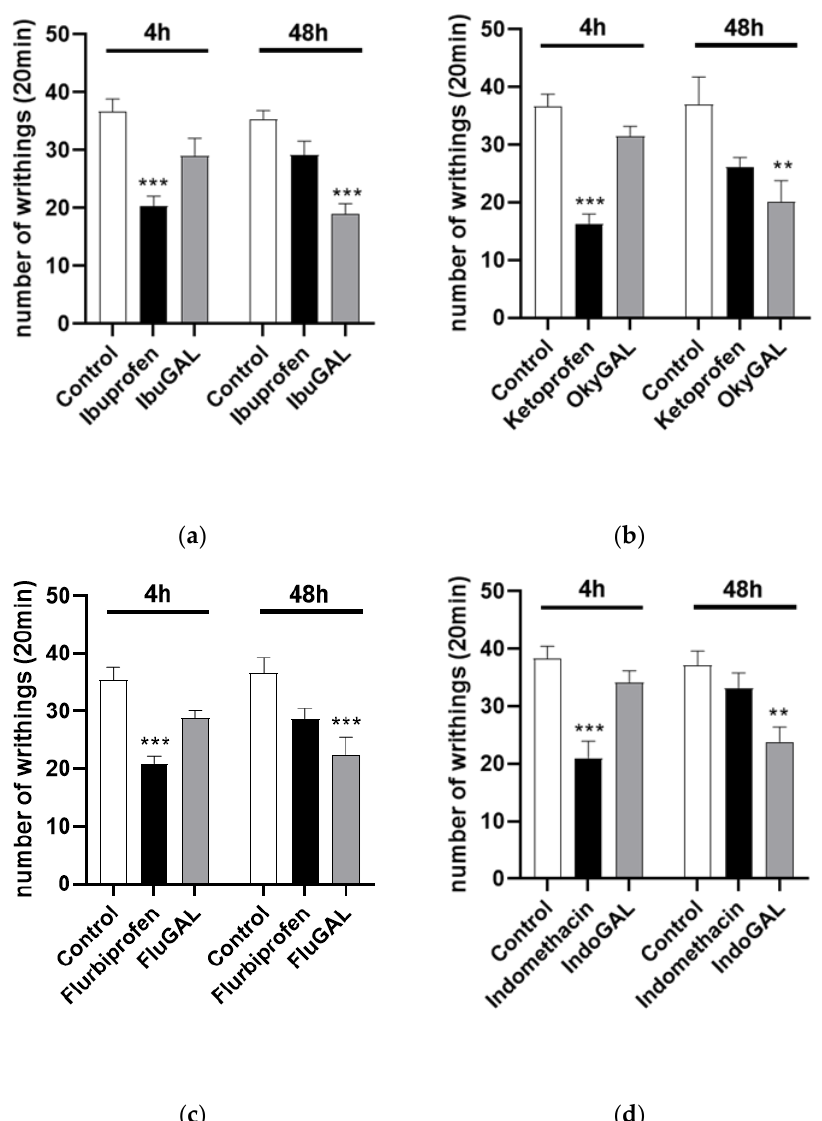
Figure 5. ( a – d ). Total number of writhing episodes within 20 min after acetic acid injection. Effect of oral administration of the parent drugs ( a ) ibuprofen, ( b ) indomethacin, ( c ) ketoprofen and ( d ) flurbiprofen and the galactosylated prodrugs ( a ) IbuGAL, ( b ) IndoGAL, ( c ) OkyGAL and ( d ) FluGAL at 4 and 48 h after administration of 0.6% acetic acid (10 mL/kg). Data are expressed as means ± S.E.M. of 6 animals. *** p < 0.001, ** p < 0.01 vs. Control.